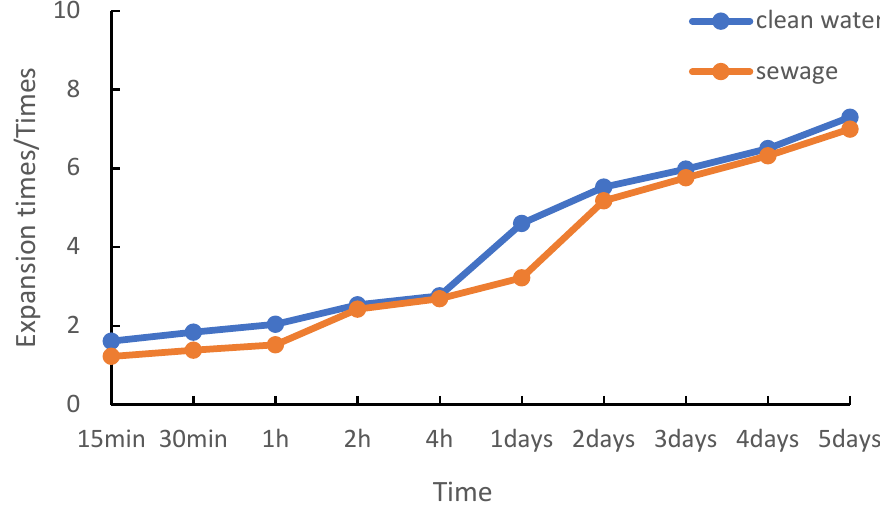
Effect of clean water and sewage on the swelling property of water swelling rubber particles When water and sewage are used for liquid preparation, the expansion multiple curve of water swelling rubber particles is shown in Figure 8: